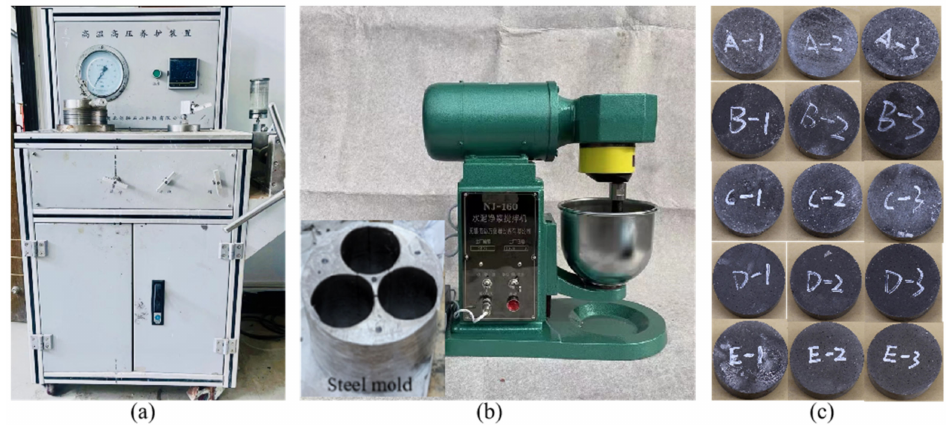
Figure 3. Preparation of cement stone specimens: ( a ) high-temperature and high-pressure curing device, ( b ) cement pouring and curing and ( c ) some prepared cement stone